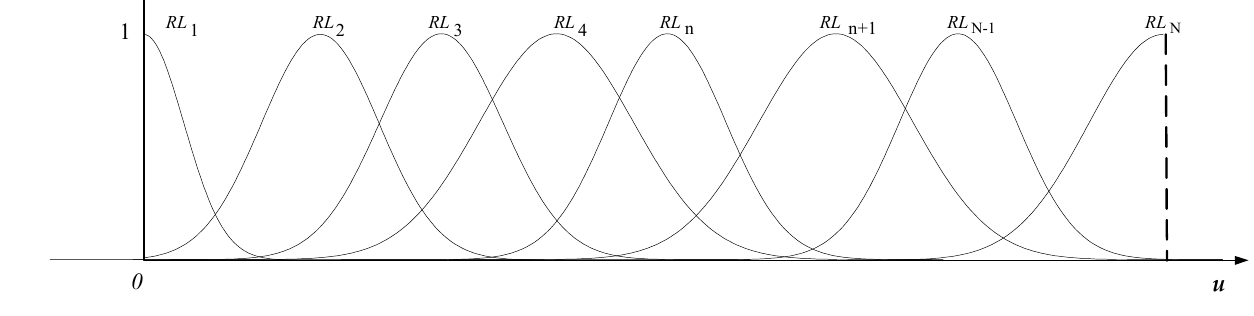
Figure 3. Fuzzy evaluation level.